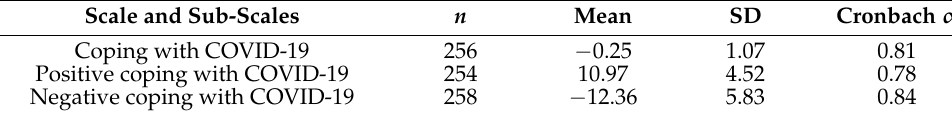
Table 3. Reliability of the scale and sub-scales.